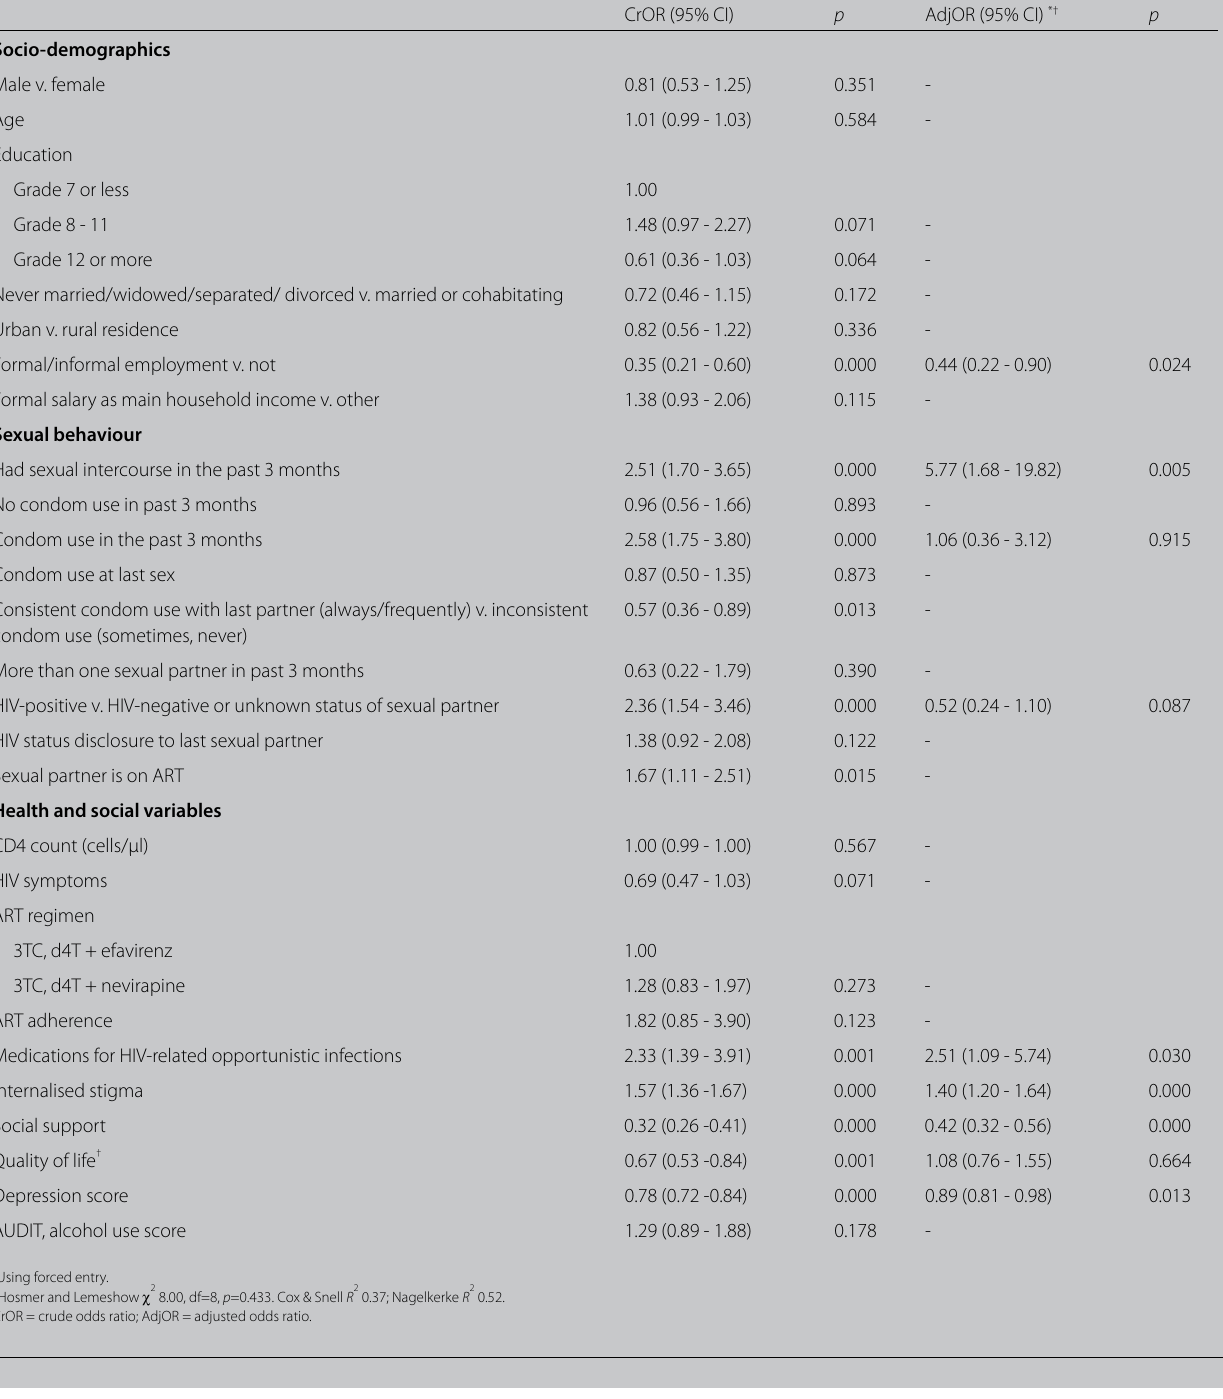
Table III. Determinants of sexual dissatisfaction at 20 months’